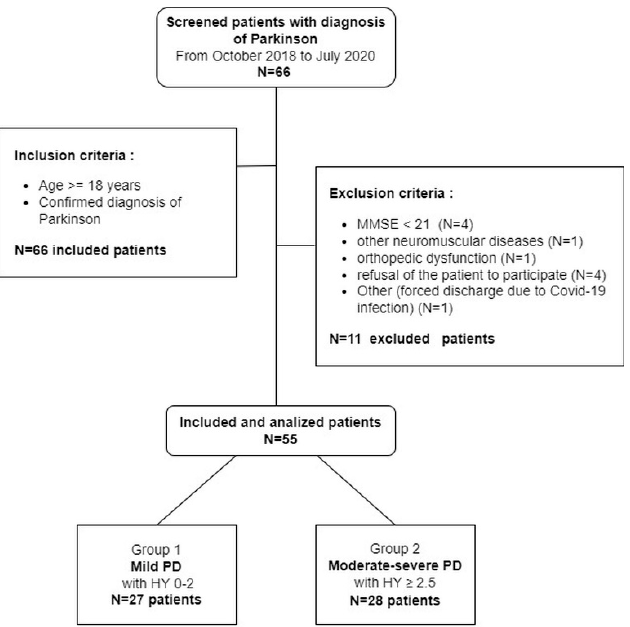
Figure 1. Flowchart of the study. Legend: MMSE = Mini-Mental State Examination; PD = Parkinson’s disease; HY = Hoehn and Yahr staging scale.